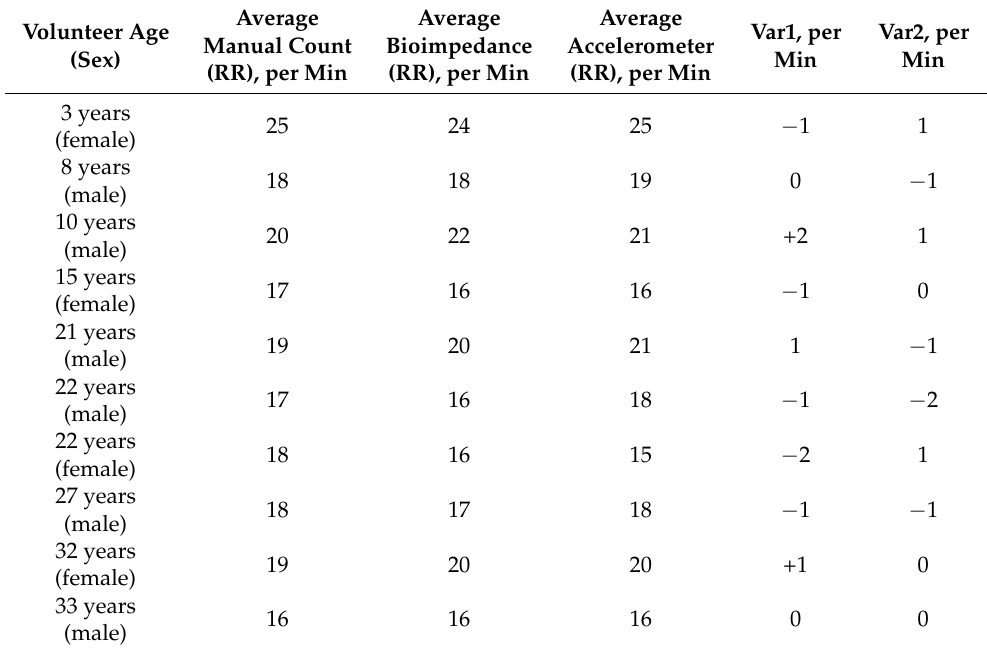
Figure 16. ( a ) Un fi ltered and ( b ) fi ltered bioimpedance and acceleration data of a male volunteer Figure 16. ( a ) Unfiltered and ( b ) filtered bioimpedance and acceleration data of a male volunteer of of age 8. age 8. Table 2. Summary of RR